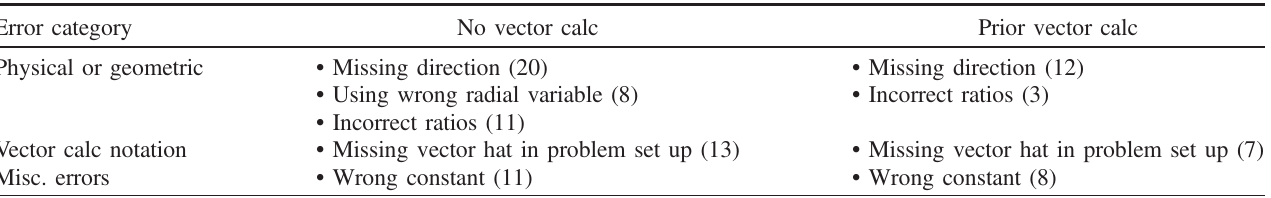
TABLE VI. Error counts from qualitative analysis of FR1b. Number in brackets is the number of students for whom we found a mistake, out of 66 total students in each category (No vector calc and prior vector calc). Error category